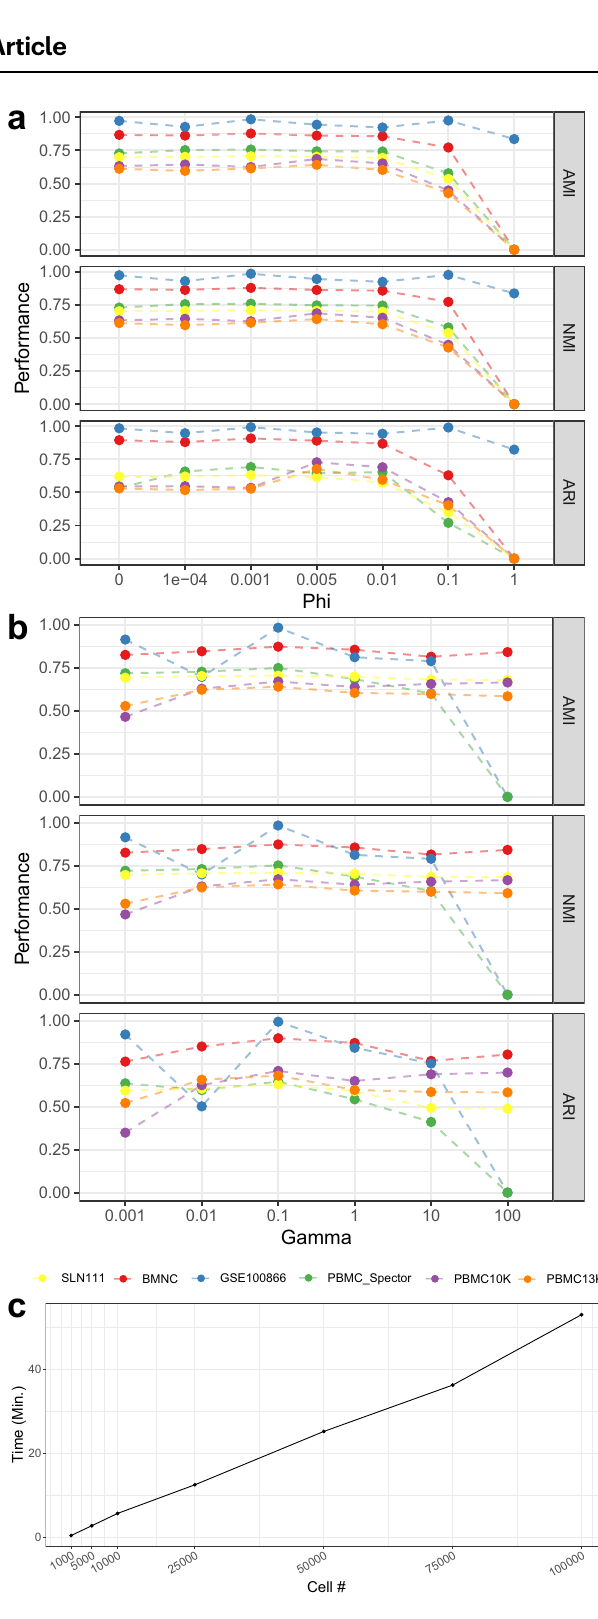
Fig. 9 | Hyperparameter tuning and running time testing of scMDC. This experiment isconducted on sixrealdatasets ( n = 6).Phi ( a )and Gamma ( b ) are set ranging from 0 to 1 and 0.001 to 100, respectively. We test the running time of scMDC by increasing the cell numbers in the simulated datasets from 1000 to 100,000 ( c , n = 7). Source data is provided as a Source Data fi